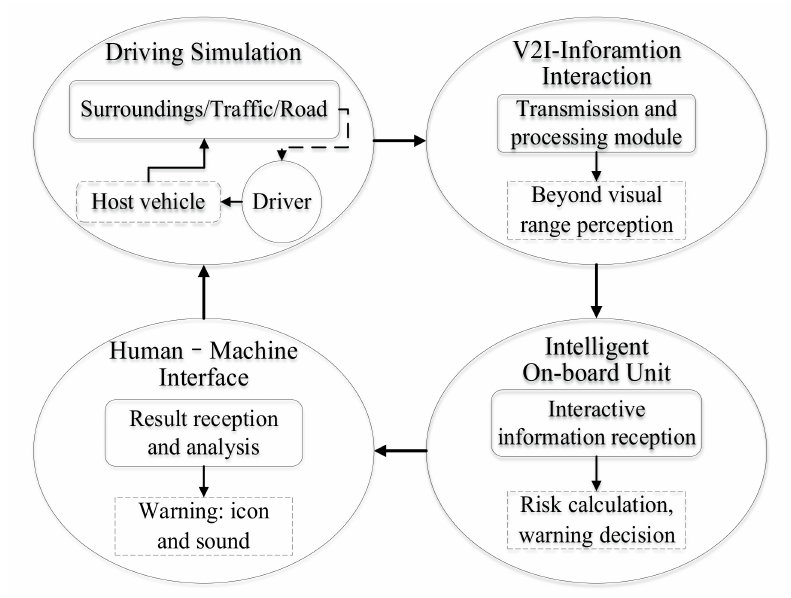
Figure 7. Function realization principle of warning